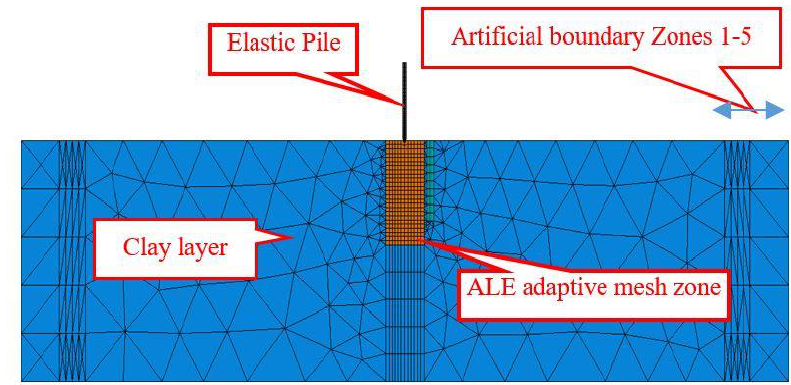
Figure 1. Driven pile near the already-installed pile.